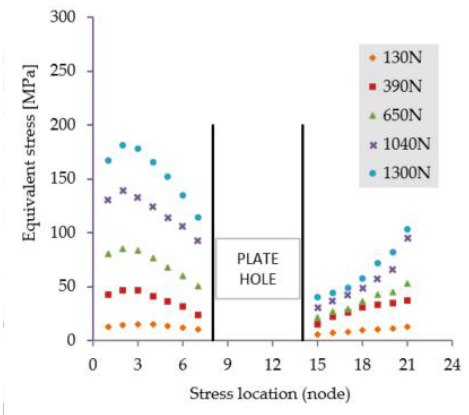
Figure 8. Stress distribution in the critical region. Scenario II.